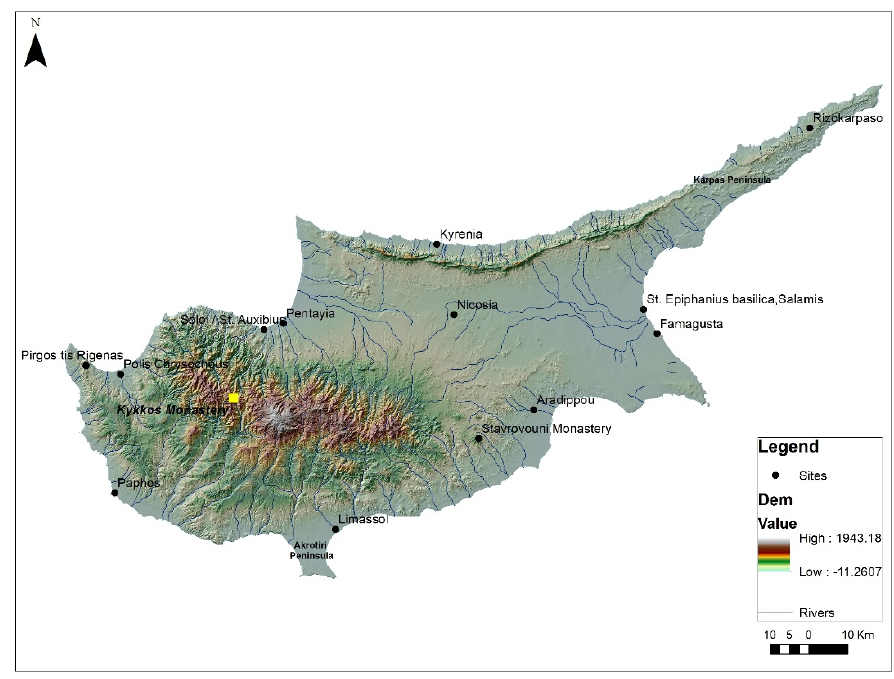
Figure 2. Map of Cyprus with toponyms and sites cited in Ambrosiana Map (Map by Niki Kyri- acou).